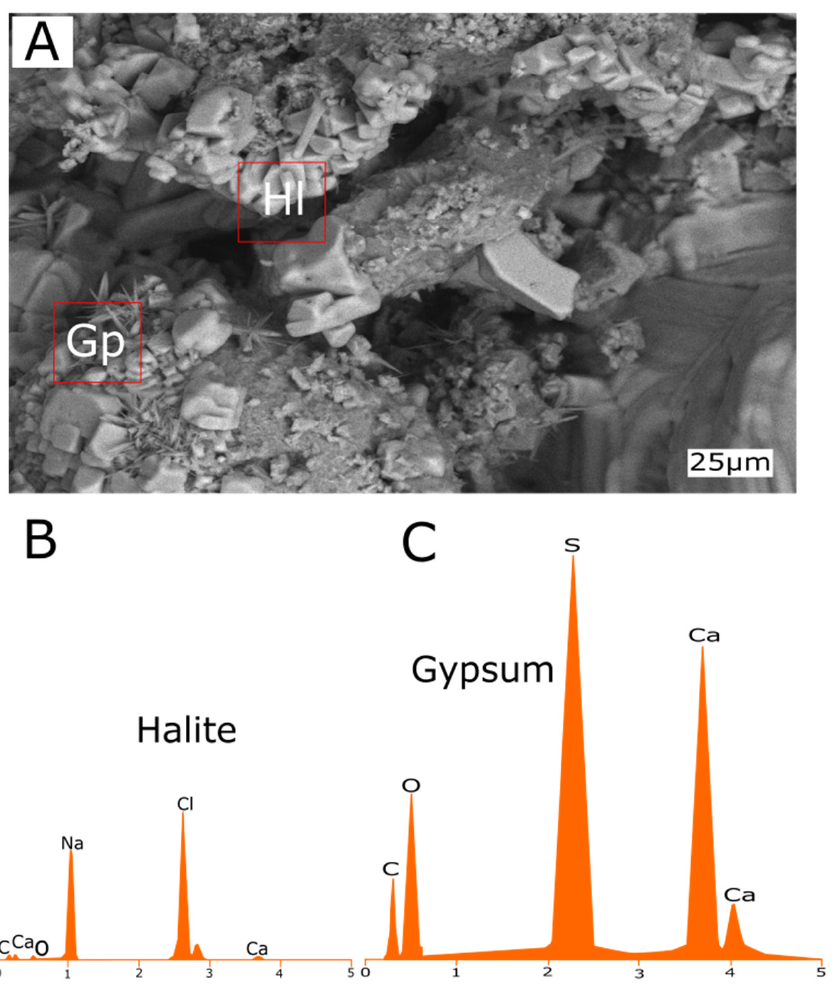
Figure 19. ( A ) Micromorphological feature of bedrock (BR) with halite cubic crystals and needle-like gypsum, and the red squares were analysed elementally using EDS. ( B , C ) EDS elemental analysis results for halite and gypsum salts for one of selected samples from bedrock of the necropolis.